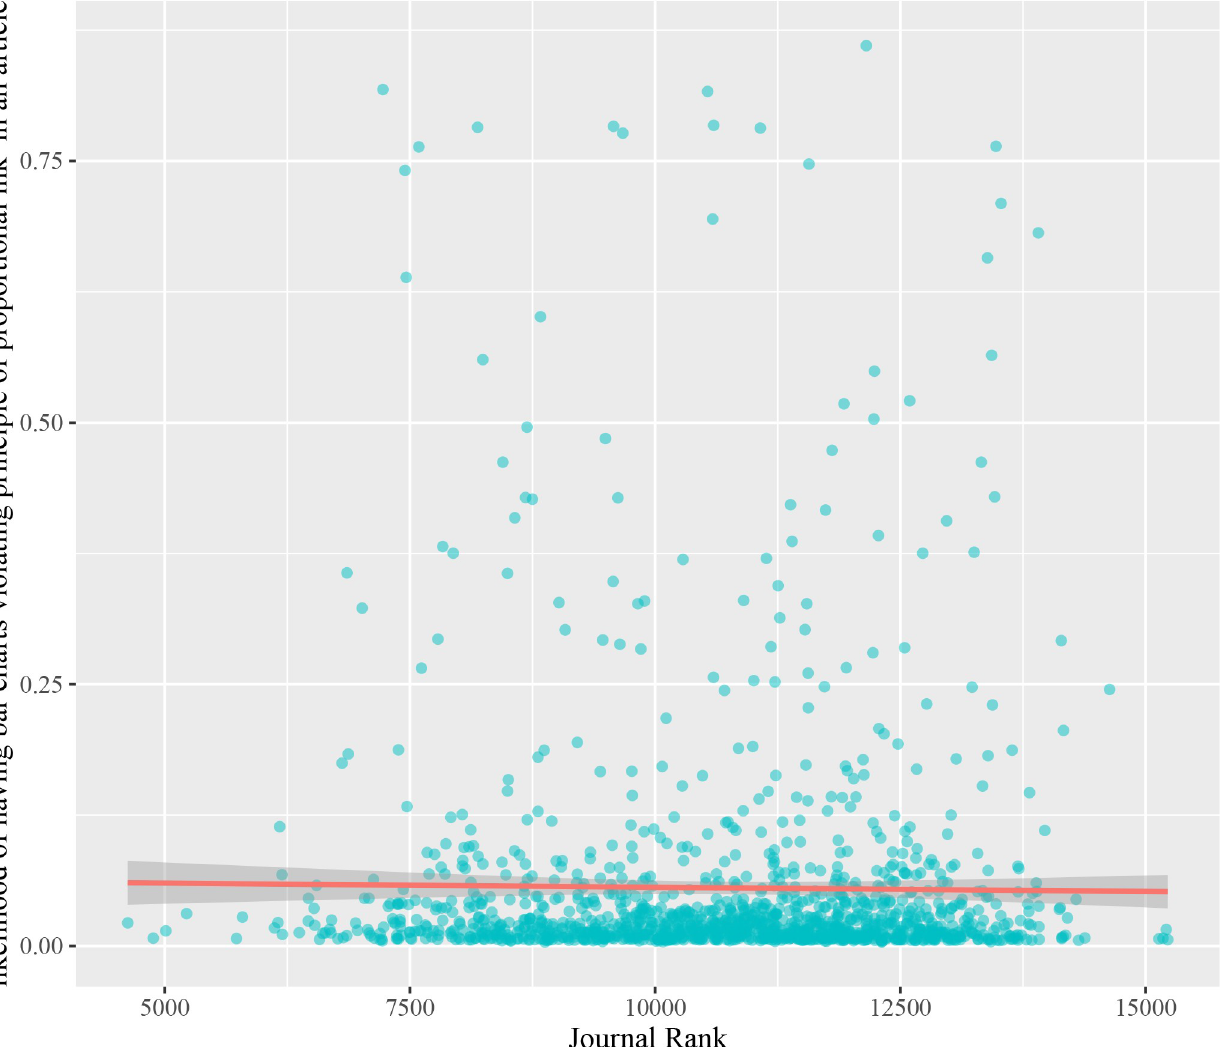
Fig 3. Correlation between journal rank and the likelihood of having articles with graphical integrity issues. No relationship between ranking and the median likelihood that an article has a bar chart violating the proportional ink